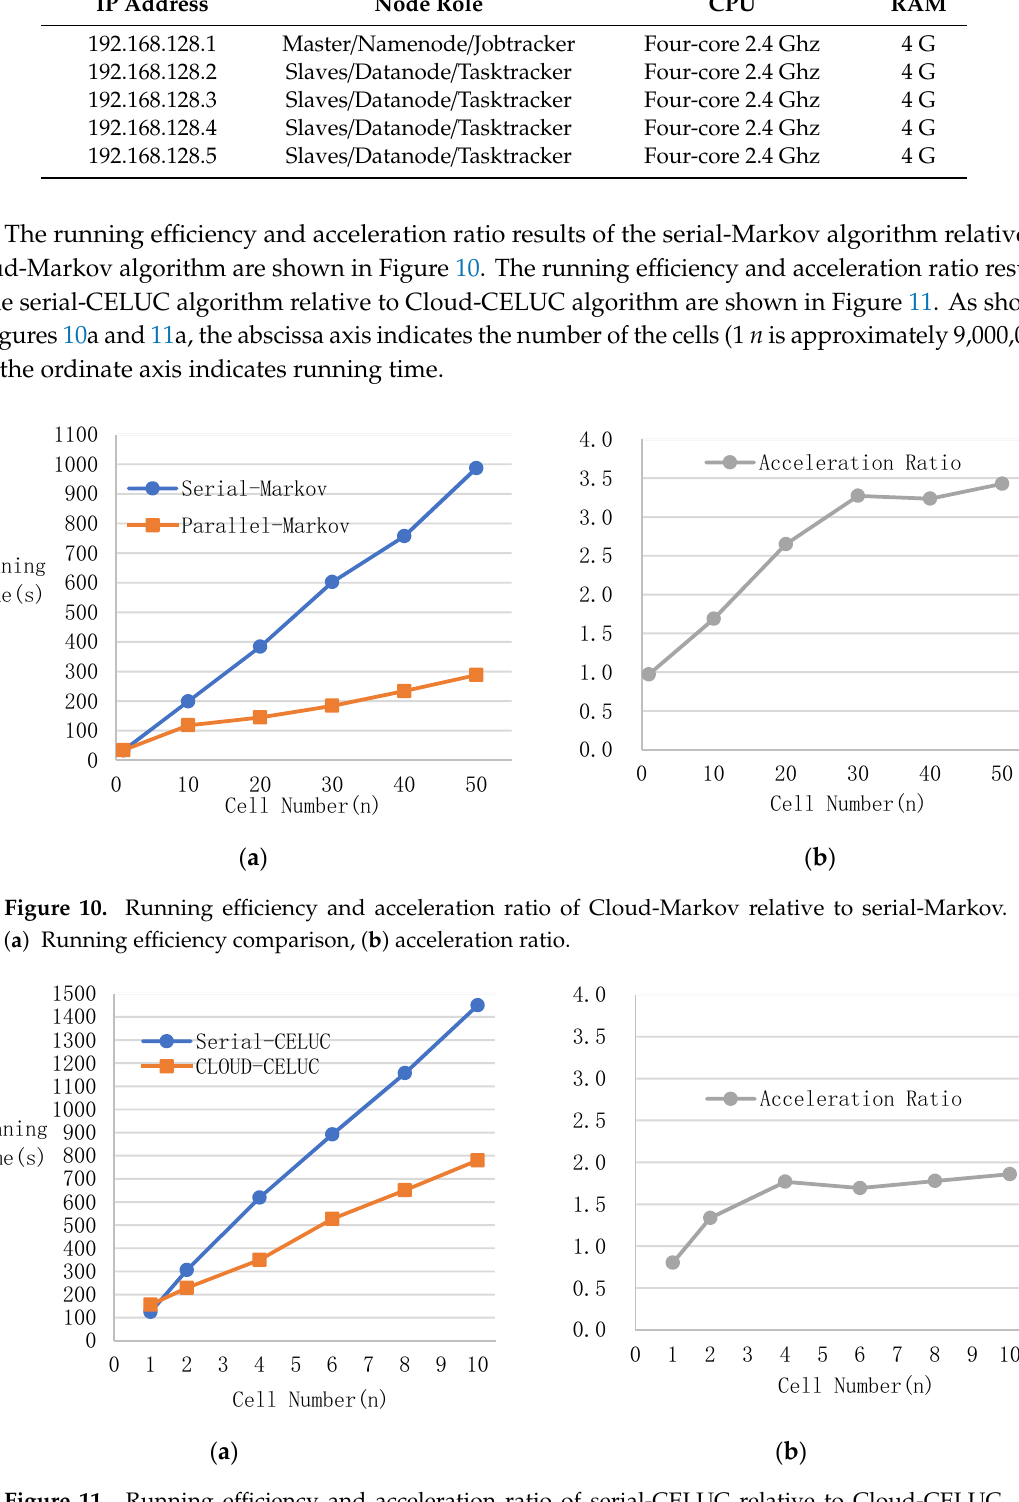
Figure 11. Running efficiency and acceleration ratio of serial-CELUC relative to Cloud-CELUC. ( a ) Running efficiency comparison, ( b ) acceleration ratio.